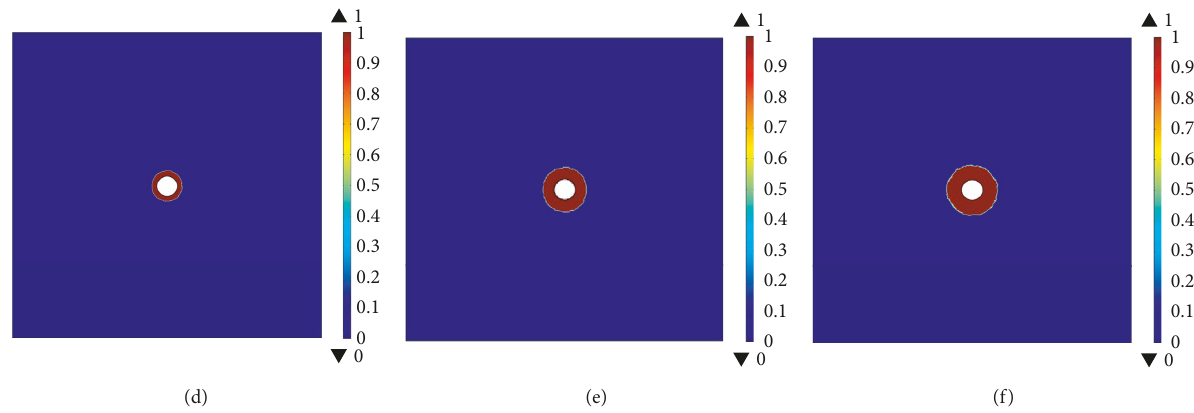
Figure 11: Distribution of the plastic region around the borehole. (a) No active support, 1d. (b) No active support, 2d. (c) No active support, 5d. (d) Active support, S 1 -1d. (e) Active support, S 1 -2d. (f) Active support, S 1 -5d.